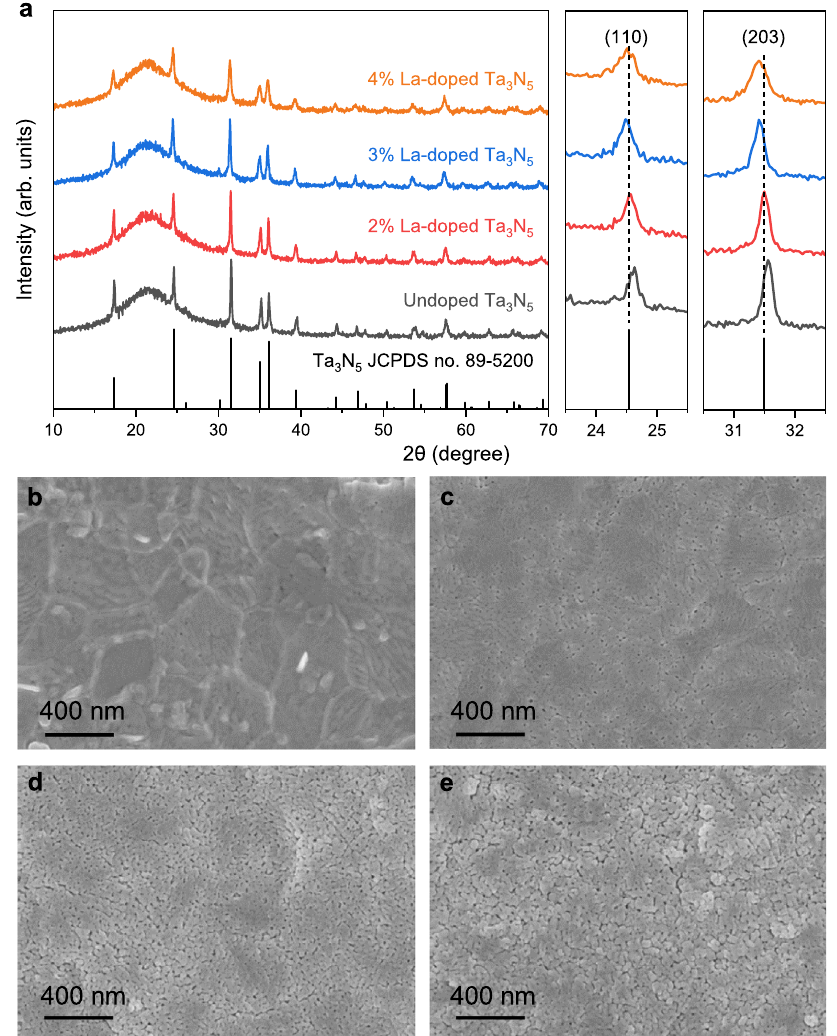
Fig. 3 | Effect of La doping on the crystallinity of the Ta 3 N 5 thin fi lms. a X-ray diffraction patterns for undoped and La-doped Ta 3 N 5 fi lms on quartz substrates. The zoomed-in image on the right side shows the Ta 3 N 5 (110) and (203) diffraction